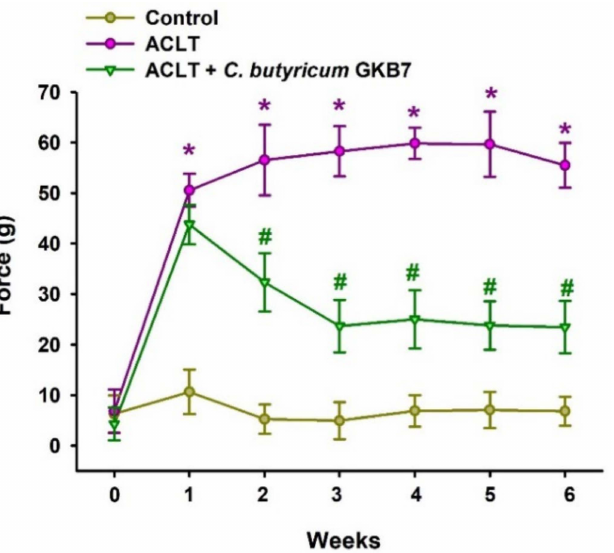
Figure 2. Oral C. butyricum GKB7 improves weight-bearing asymmetry. Behavioral testing for pain suggested that by postoperative week 2, rats in the ACLT + C. butyricum GKB7 group were in less pain than rats in the ACLT-only group. * p < 0.05 ACLT-only vs. controls; # p < 0.05 ACLT-only vs. ACLT + C. butyricum